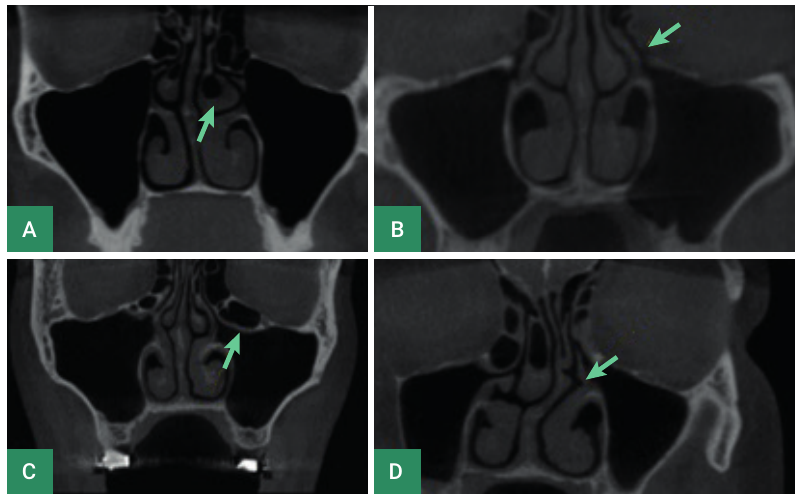
Figure 4. (A) Concha bullosa, (B) Hipertrophy of the uncinate process, (C) Haller Cell, (D) Nasal septum deviation